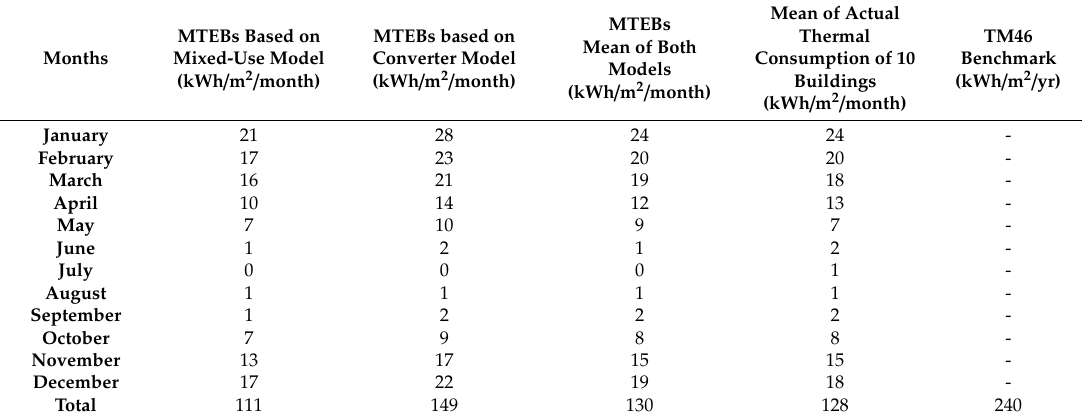
Table 7. MTEBs against TM46 UC benchmark and actual thermal